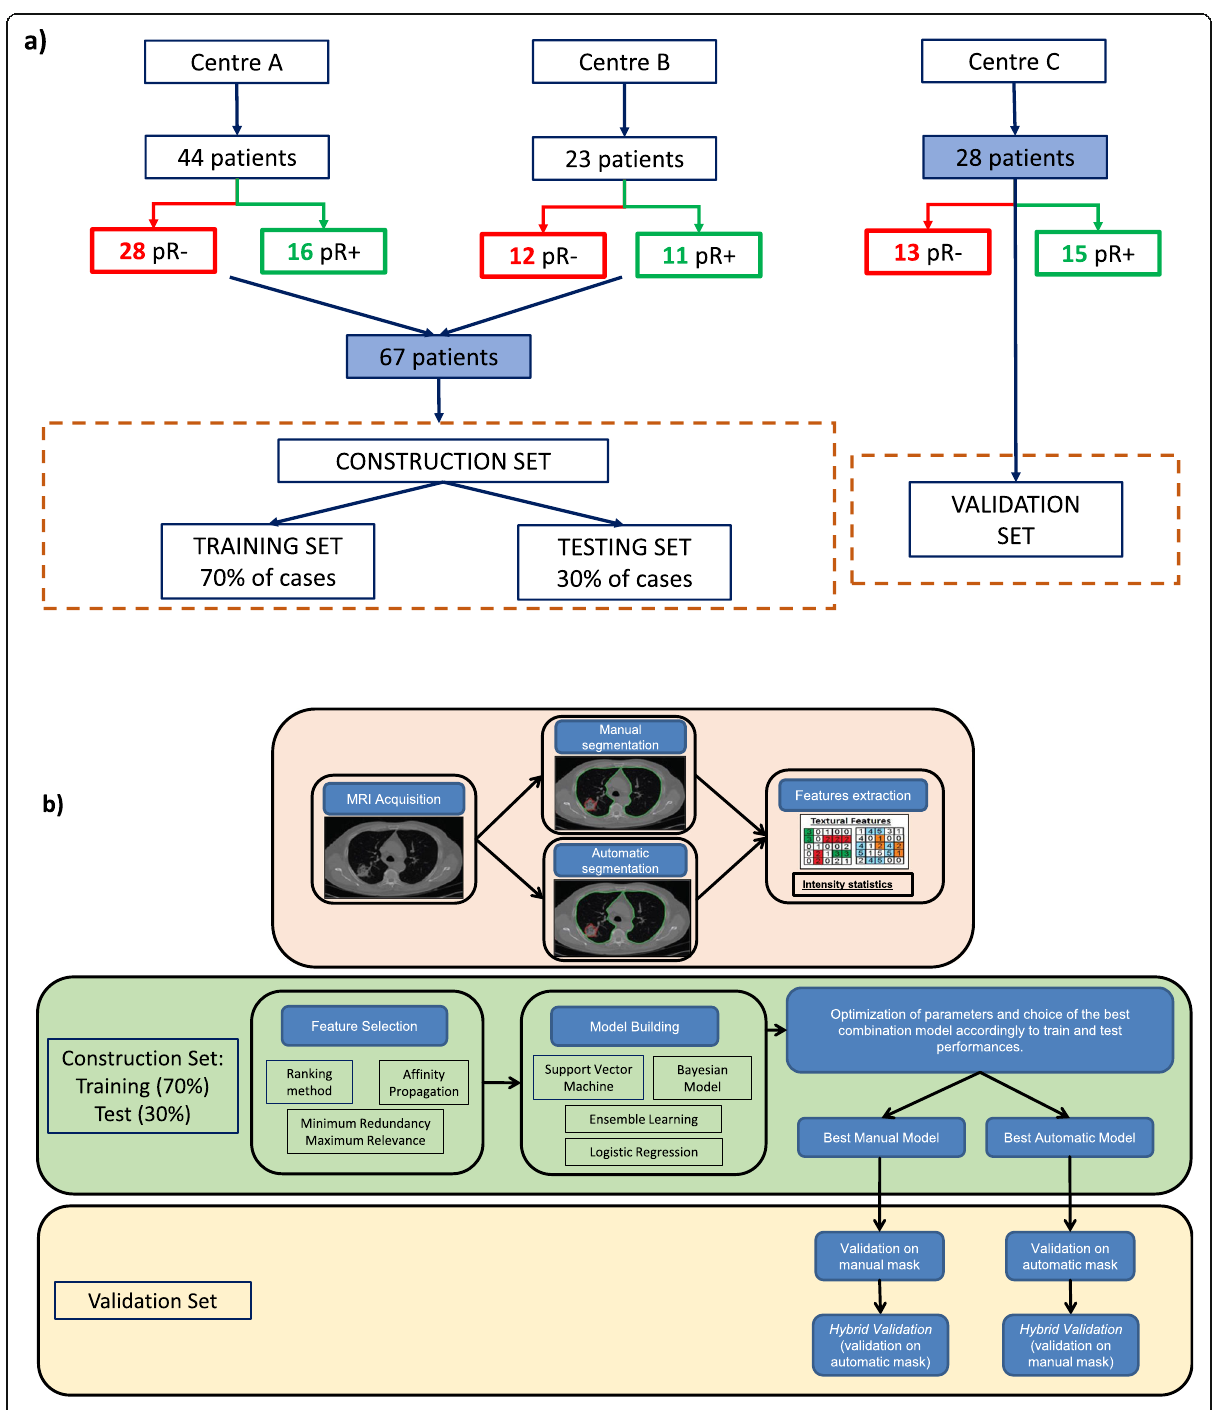
Fig. 2 Flowchart explaining the dataset subdivision ( a ). Flowchart illustrating the radiomics pipeline ( b ). pR Nonresponders, pR+